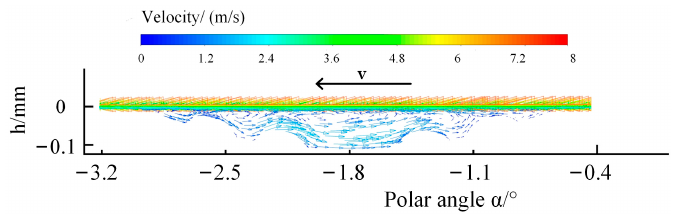
Figure 9. Circumferential profile velocity streamlines of the single circular pit.